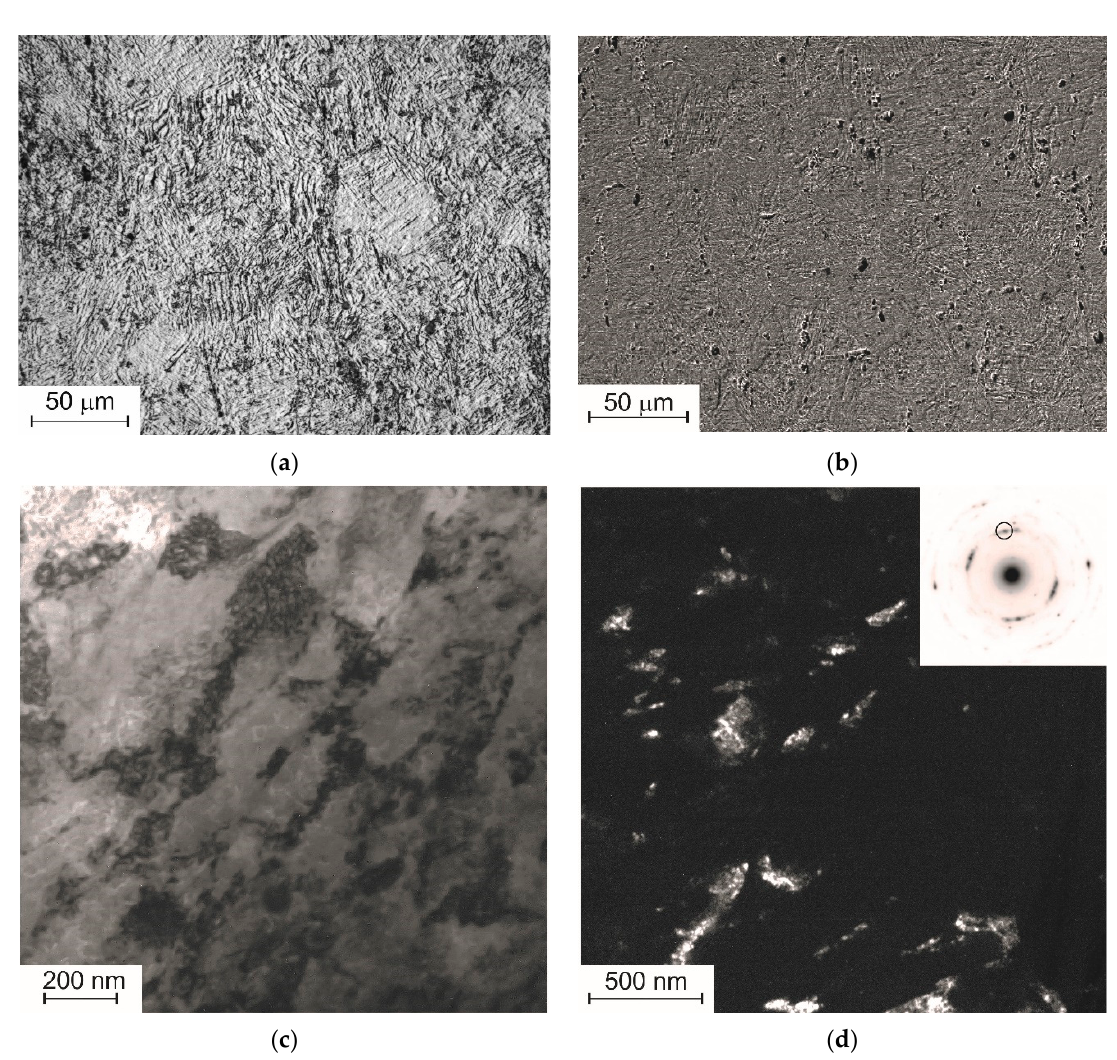
Figure 3. Microstructure of sample after abc-pressing to e = 5.4: ( a ) optical microscopy, ( b ) scanning electron microscopy, ( c , d ) transmission electron microscopy ( c bright-field image, d dark-field image taken using the R-phase reflection of (211) type which is denoted by circle in insertion).